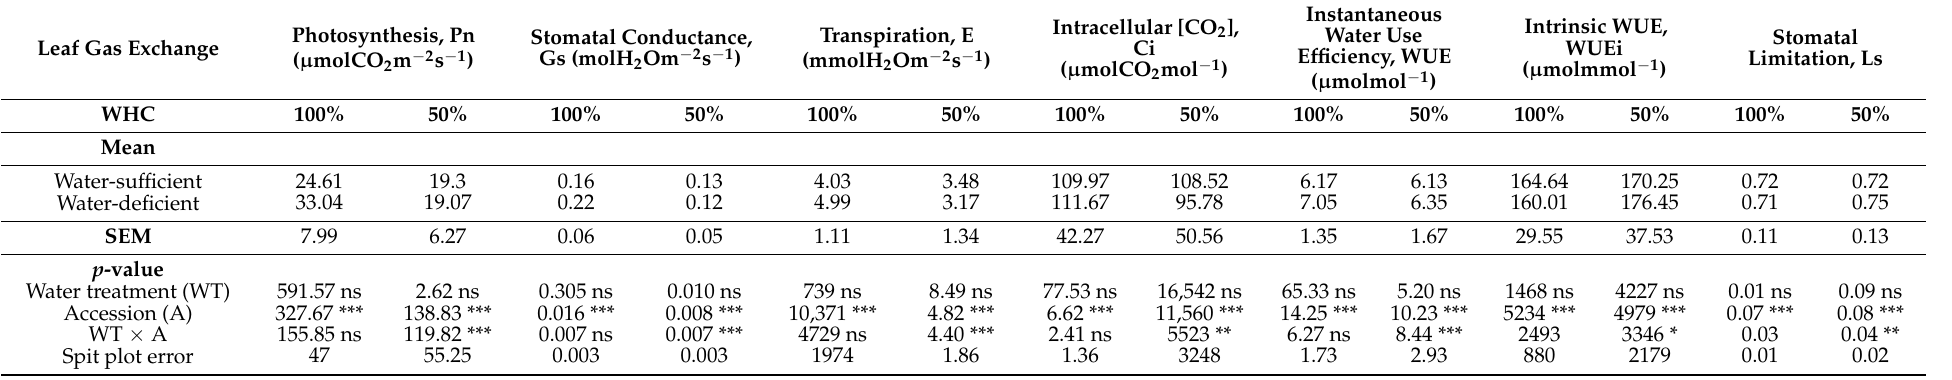
Table 5. Mean and the analysis of variance of leaf gas exchange measurements in 44 A. tricolor accessions at different water holding capacity (WHC) evaluated in Trial II (n = 4). Data